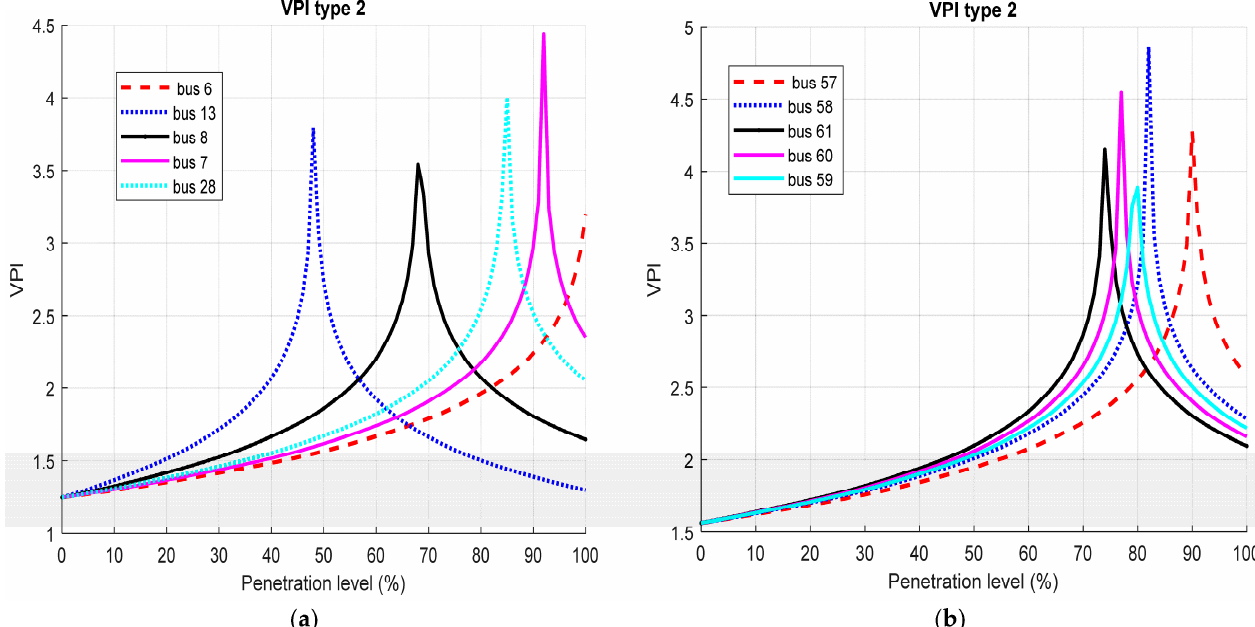
Figure 18. VPI when Type 2 DG was connected to the selected buses of IEEE ( a ) 33-bus ( b ) 69-bus RDNs.